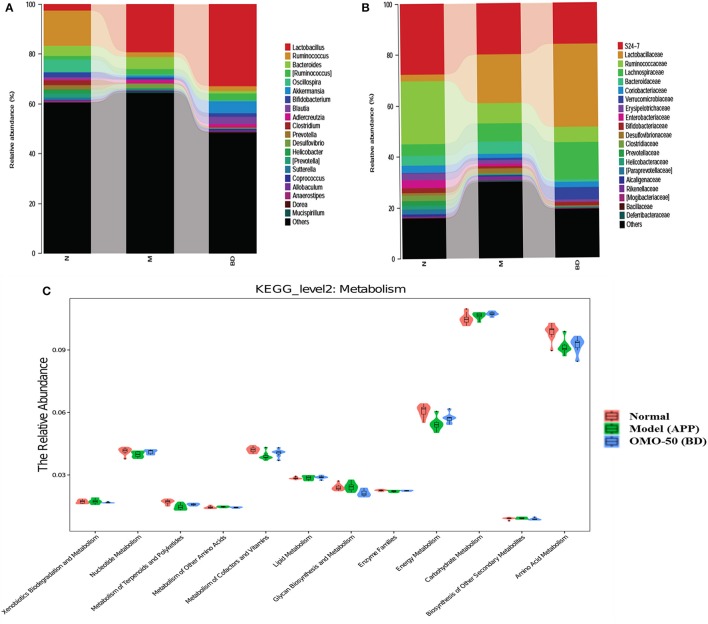
Effects of OMO on the microbiota in fecal samples from the APP/PS1 transgenic mice. The graph in (A) shows the classification and abundance of fecal contents at the phylum level, (B) shows the classification and abundance of fecal contents at the family level, and (C) shows the results of the KEGG pathway enrichment analysis of the gut microbiota with respect to the metabolic systems. Values are presented as the means of six independent experiments. N denotes the control group, M represents the APP/PS1 transgenic group, and BD designates the 50 mg/kg OMO-treated group.